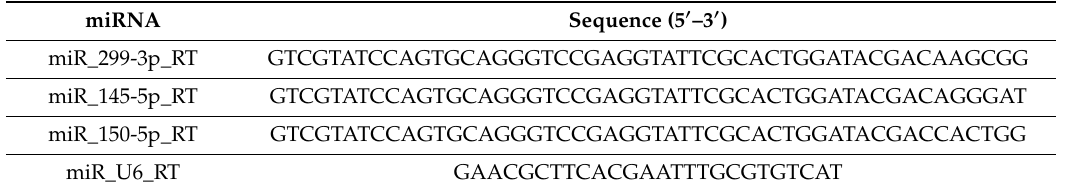
Table 2. The primers for the stem and loop reverse transcription (RT) protocol.